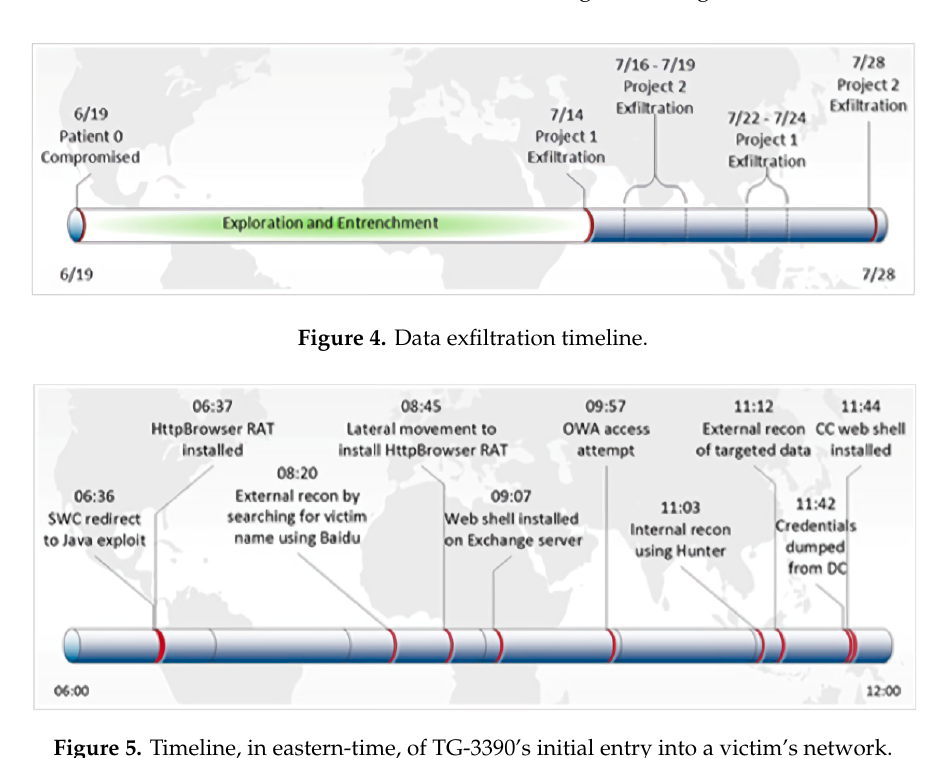
Figure 6. Timeline, in eastern-time, of TG-3390’s reentry into a compromised network.